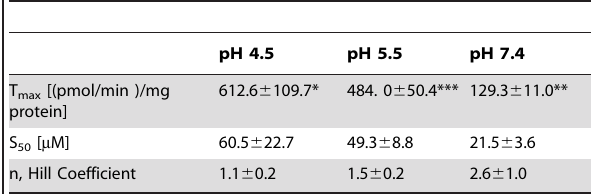
Table 1. Transport kinetic parameters of Oatp4c1-mediated E3S transport at pH 4.5, 5.5 and 7.4 (mean 6 S.E.).